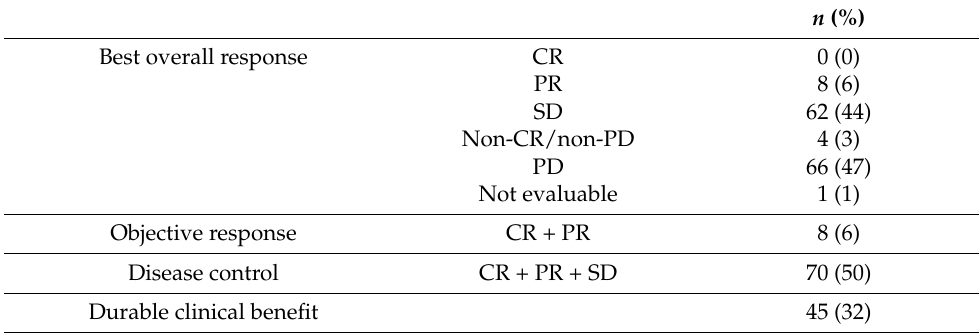
Table 2. Efficacy of pazopanib monotherapy in the study patients ( n = 141).